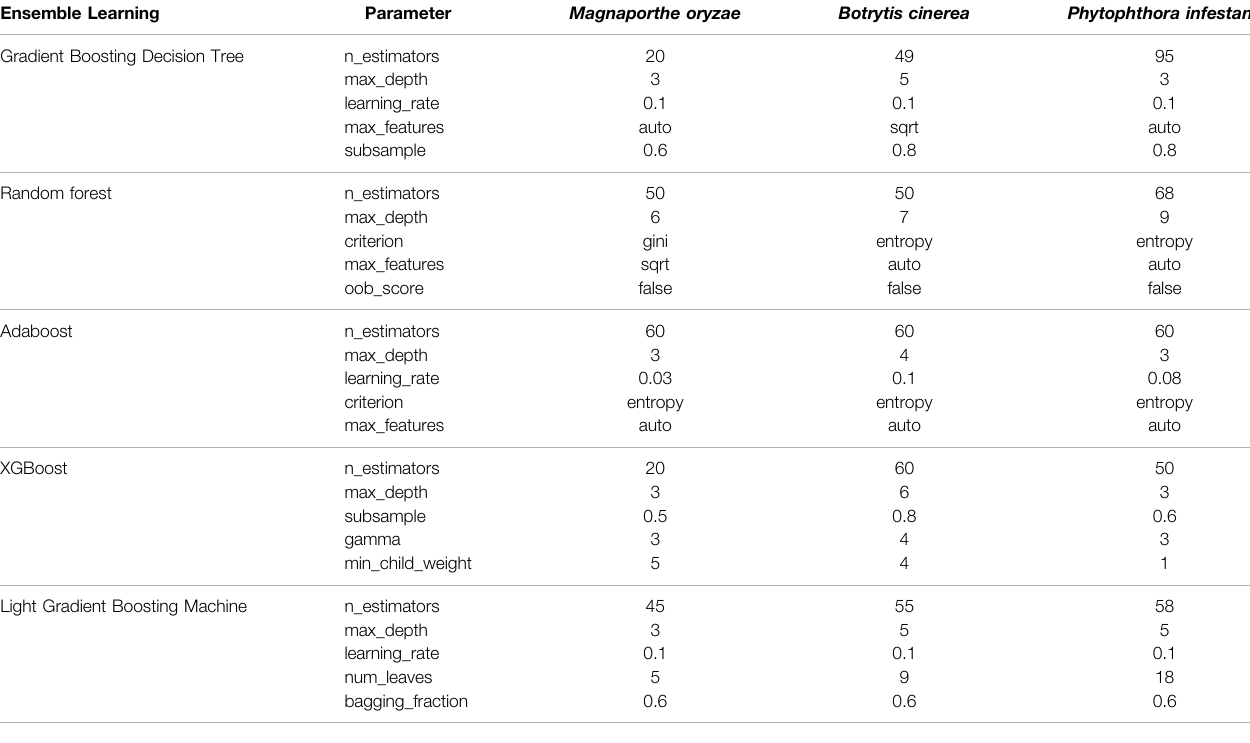
TABLE 6 | The optimal parameters obtained from the training of the fi ve models. Ensemble Learning